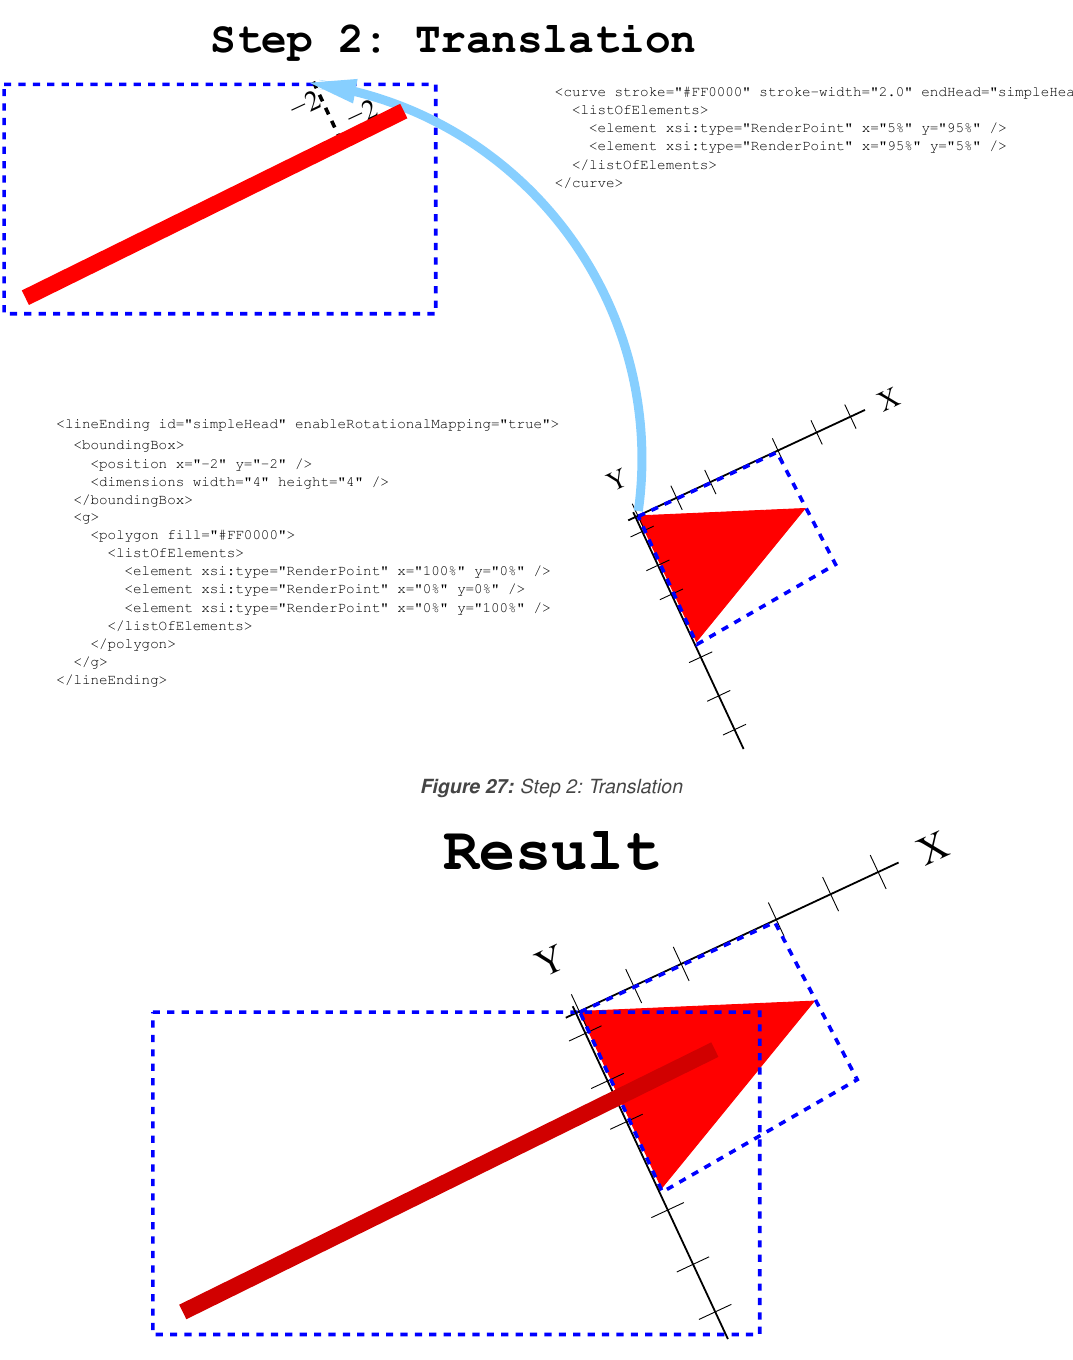
Figure 28: Curve with mapped arrow head and rotational